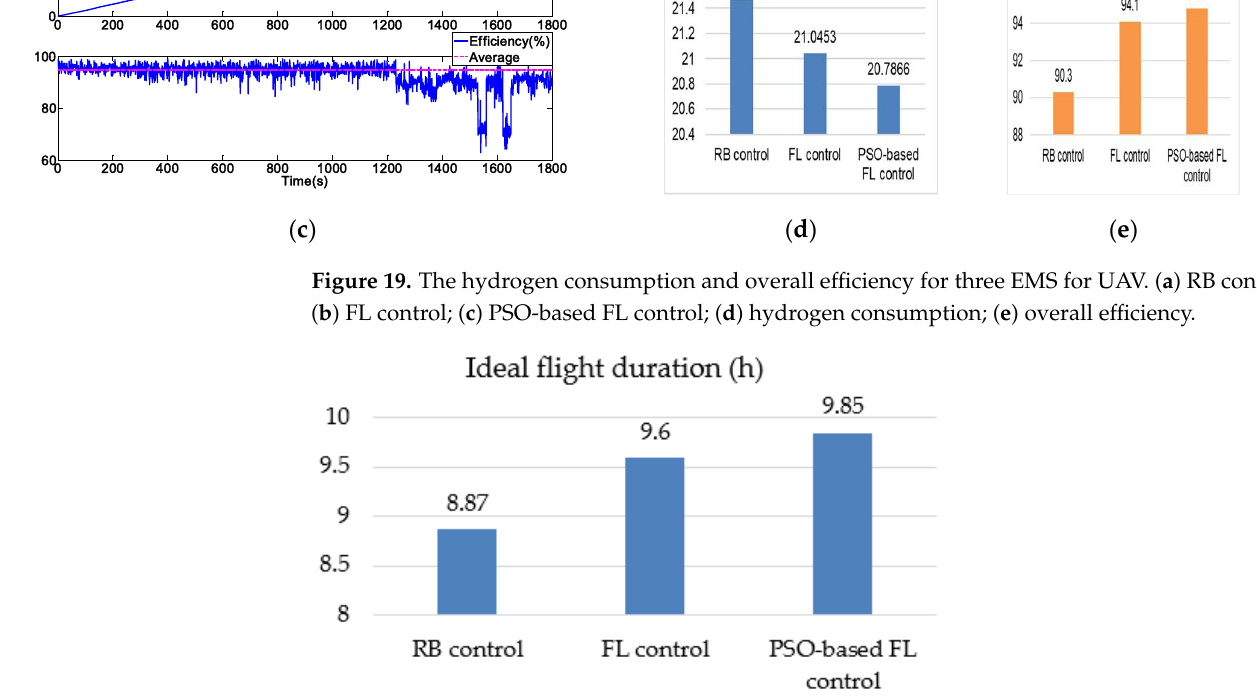
Figure 21. Efficiency curve of the fuel ‐ cell. 5.3. Analysis on Stress and DC Bus Voltage Stability In order to further investigate the performance of different EMSs of UAV, the stress for each energy source and the stability of the DC bus voltage should be considered. It is believed that the power response with high frequency and fluctuations will increase the chemical stress inside the stack and aggravate the performance degradation of the fuel ‐ cell of the UAV. The internal stress of energy sources can be evaluated by an approach based on the Haar wavelet transform and a fascinating feature of which the mean value of the decoupled high ‐ frequency component is zero [32]. Thus, the standard deviations of this component can be used to estimate how often the energy sources are solicited for the UAV. This approach is also suitable for estimating the stability of the DC bus voltage of HEPS for a long time. The detailed results of the decoupling analysis are shown in Figure 22, and the stand ‐ ard deviation can be seen in Table 4. In Figure 22a,d, the output power curve of the fuel ‐ cell, output power of the battery and the DC bus voltage waveform can be transformed